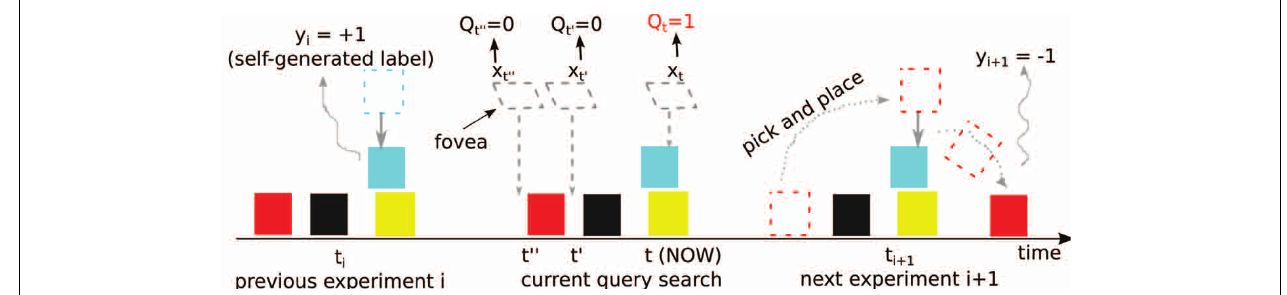
FIGURE 3 | A single robot-environment interaction, illustrating a setting change. Each pick and place “experiment” causes a change in setting. The outcome of the previous experiment was that the robot placed the blue block on top of the yellow block, and observed the label + 1, corresponding to “stable.” Now (middle), the robot examines three fovea locations ( t , t (cid:2) and